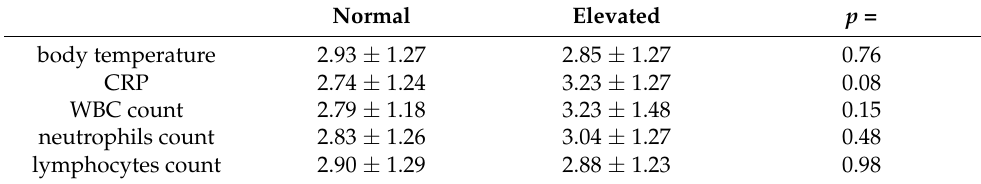
Table 3. The mean TSH levels ( ± SD) at the initial visit in children with and without fever, with and without elevated C-reactive protein (CRP), with and without elevated white blood cells (WBCs), with and without elevated neutrophils and with and without elevated